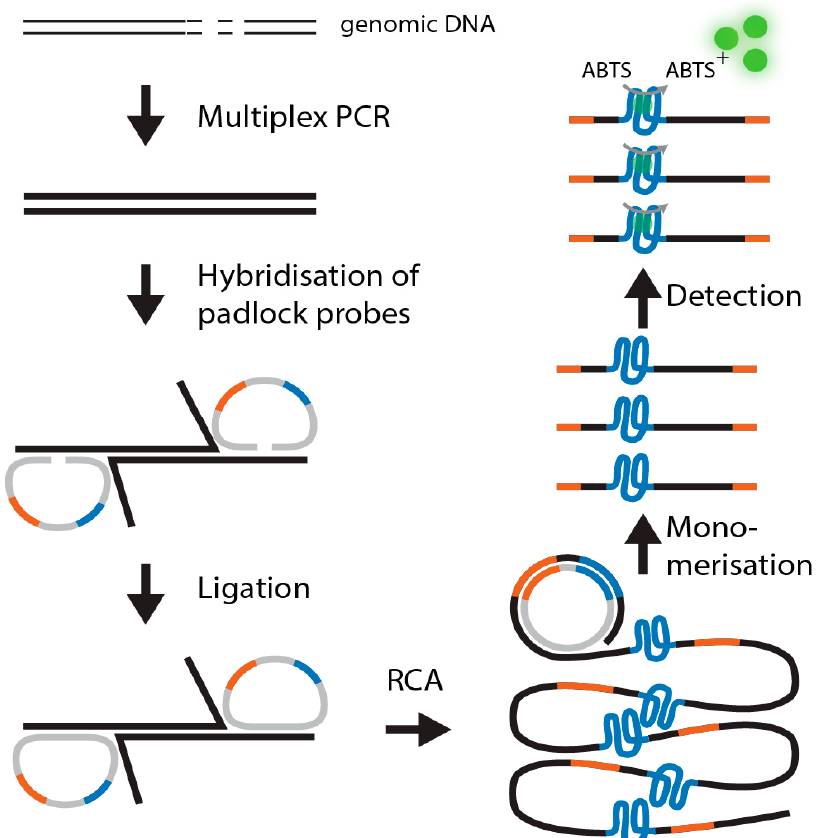
Figure 1. G-quadruplex padlock probe protocol. First, genomic DNA is amplified by a 45-plex PCR targeting antibiotic resistance genes. Then, padlock probes hybridize to the target. Next, the probes are ligated and circularized. Circularized probes are amplified in an RCA. The probes are then monomerized by enzymatic digestion, and finally, the active DNAzyme is detected in a colorimetric reaction.